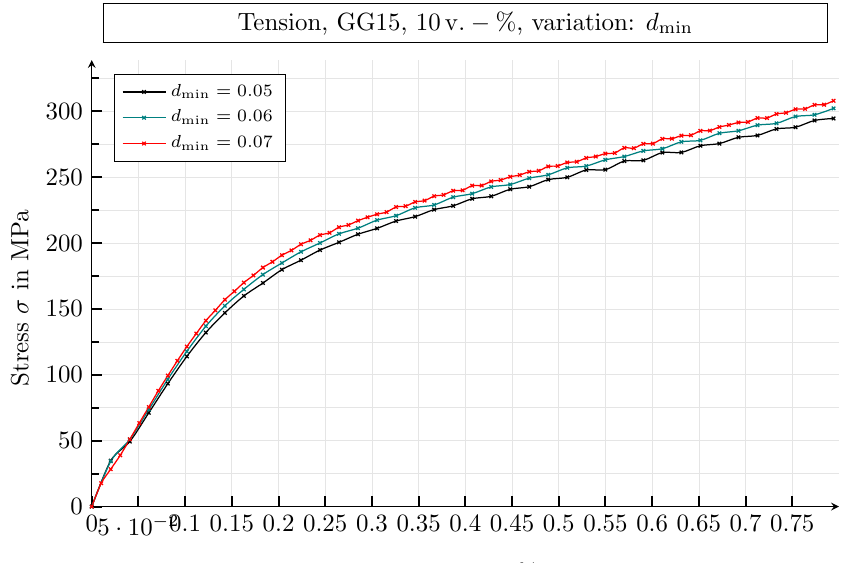
Figure 10. Influence of the minimum value of the degradation function on the macroscopic stress– strain behaviour. Simulations at room temperature, using GJL-150 SVEs with a graphite flake volume fraction of 10v. %. For a constant threshold of volume change, ε crit − the degradation function varies for the values d min =